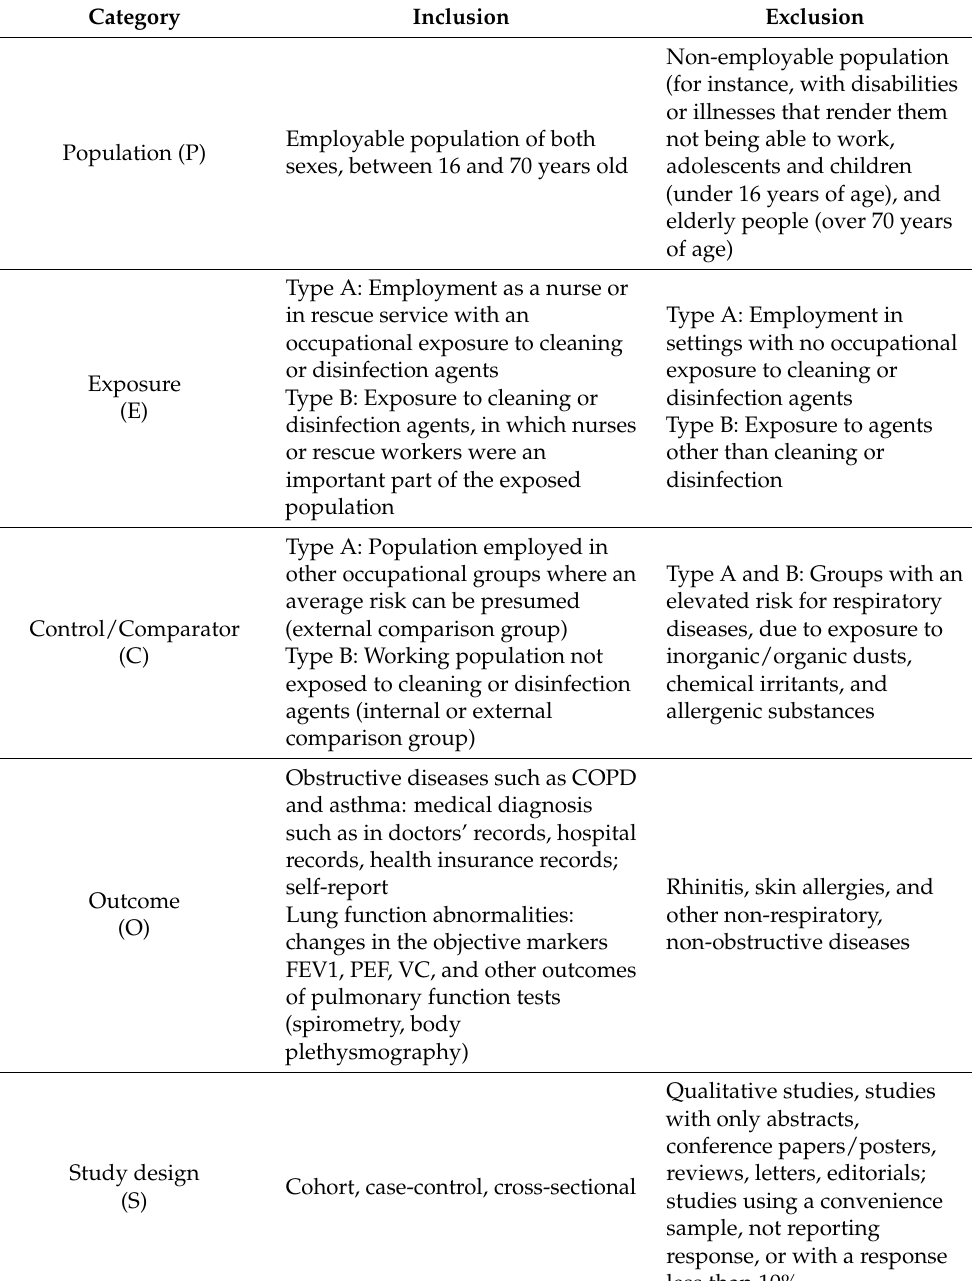
Table 1. Study eligibility criteria according to Population, Exposure, Comparison, Outcome, and Study